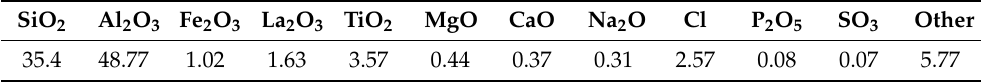
Table 4. Oxide composition of the zeolitic by-product (%), according to X-ray fluorescence. SiO